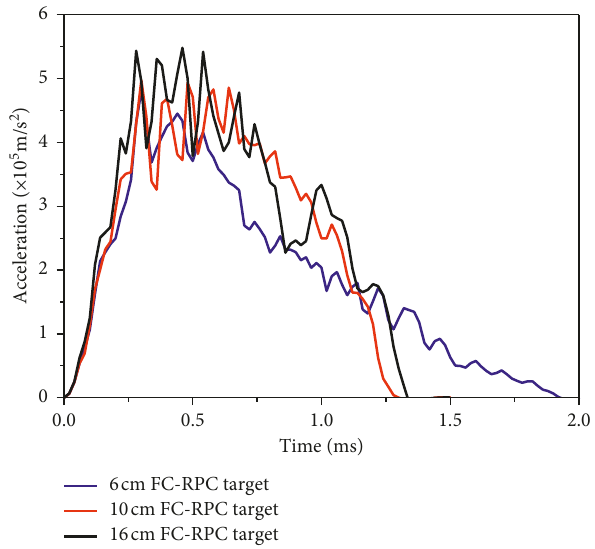
Figure 21: Acceleration time history curves of projectiles pene- tration FC-RPC targets.